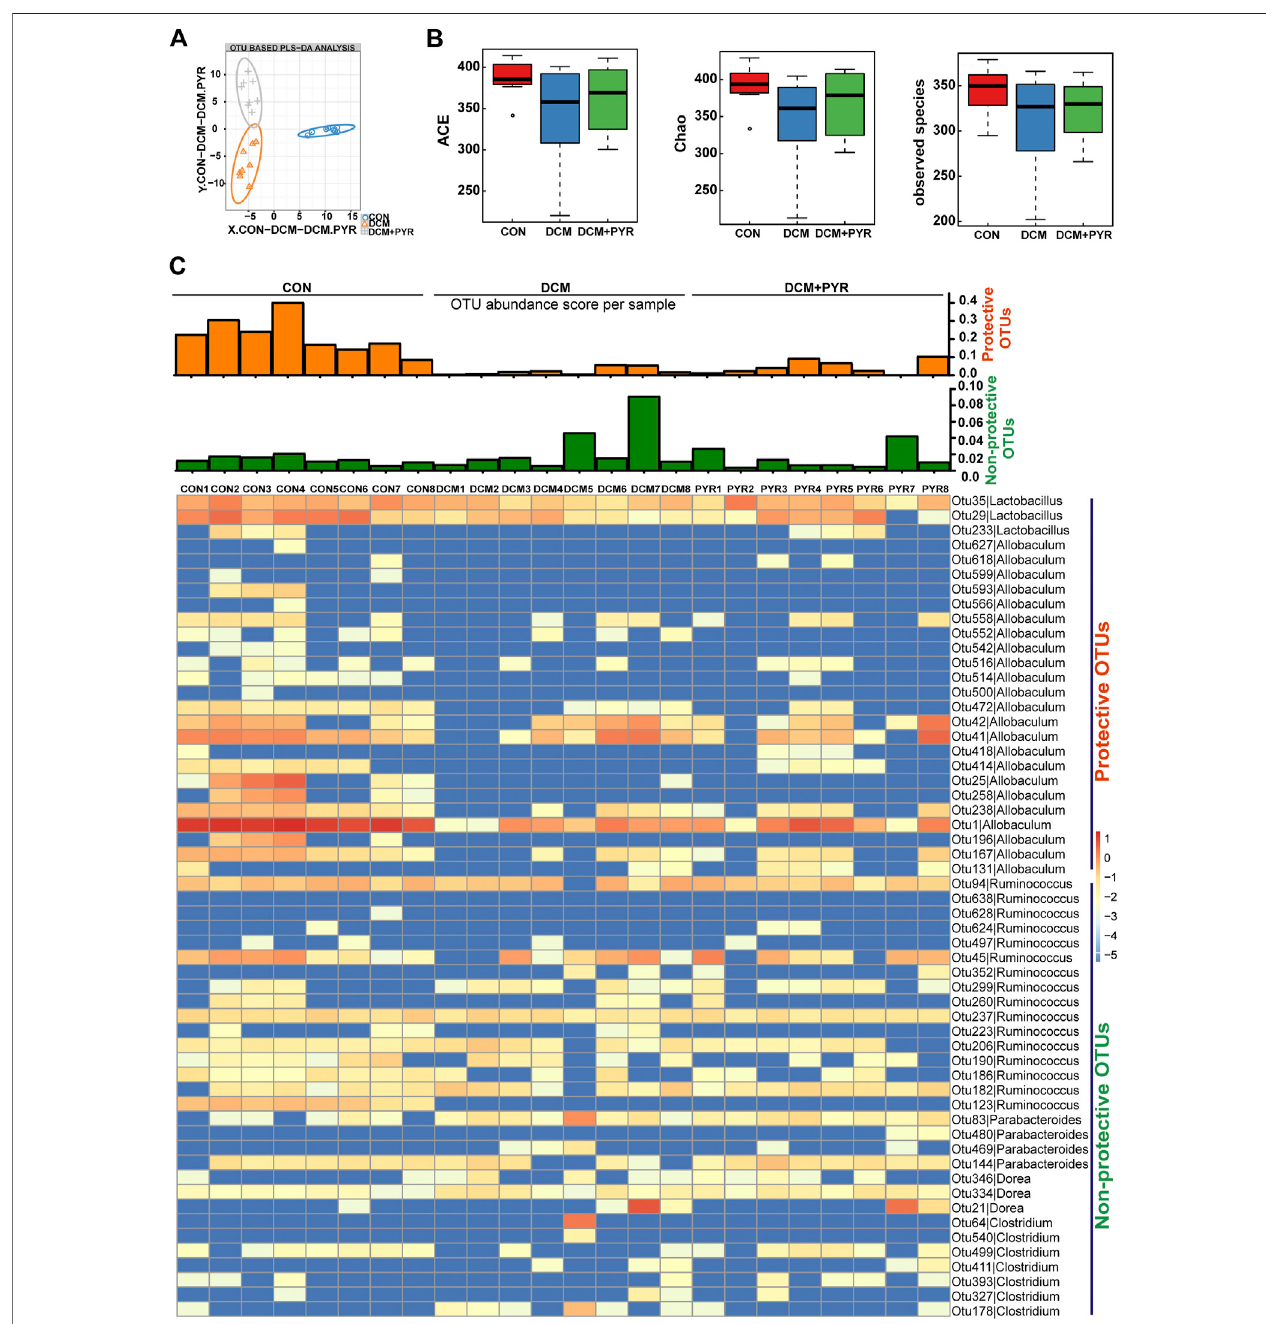
FIGURE 3 | Pyridostigmine restructured gut microbiota homeostasis in diabetic cardiomyopathy mice. (A) PLS-DA of gut microbes based on the OTU data of the groups. (B) α -diversity indices (ACE, Chao, and observed species) from fecal sample 16 S rDNA sequencing data. (C) Heatmap of differentially abundant OTUs among CON, DCM, and DCM + PYR groups. The rows present the 56 OTUs identi fi ed in mouse fecal samples. The columns depict the mice in CON, DCM, and DCM + PYR groups. The bar graphs above the heatmap present the abundance scores of potentially protective (orange) and non-protective (green) OTUs calculated for each mouse group. n (cid:1)